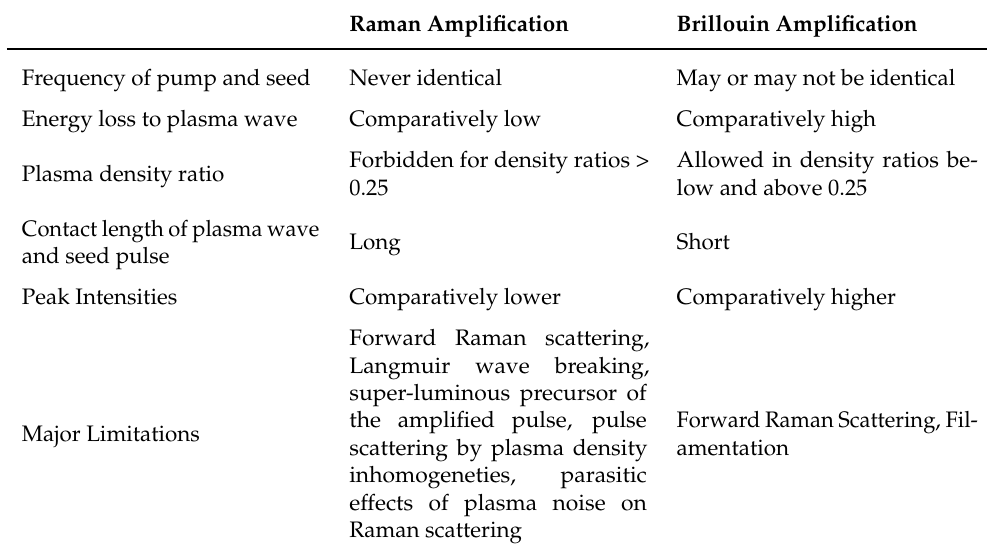
Table 1. Comparison between Raman and Brillouin amplification.